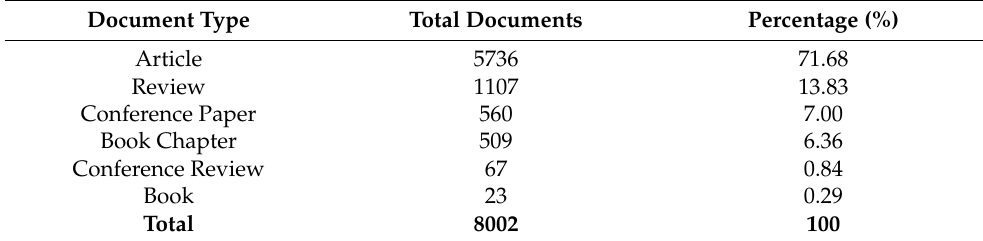
Table 1. Document